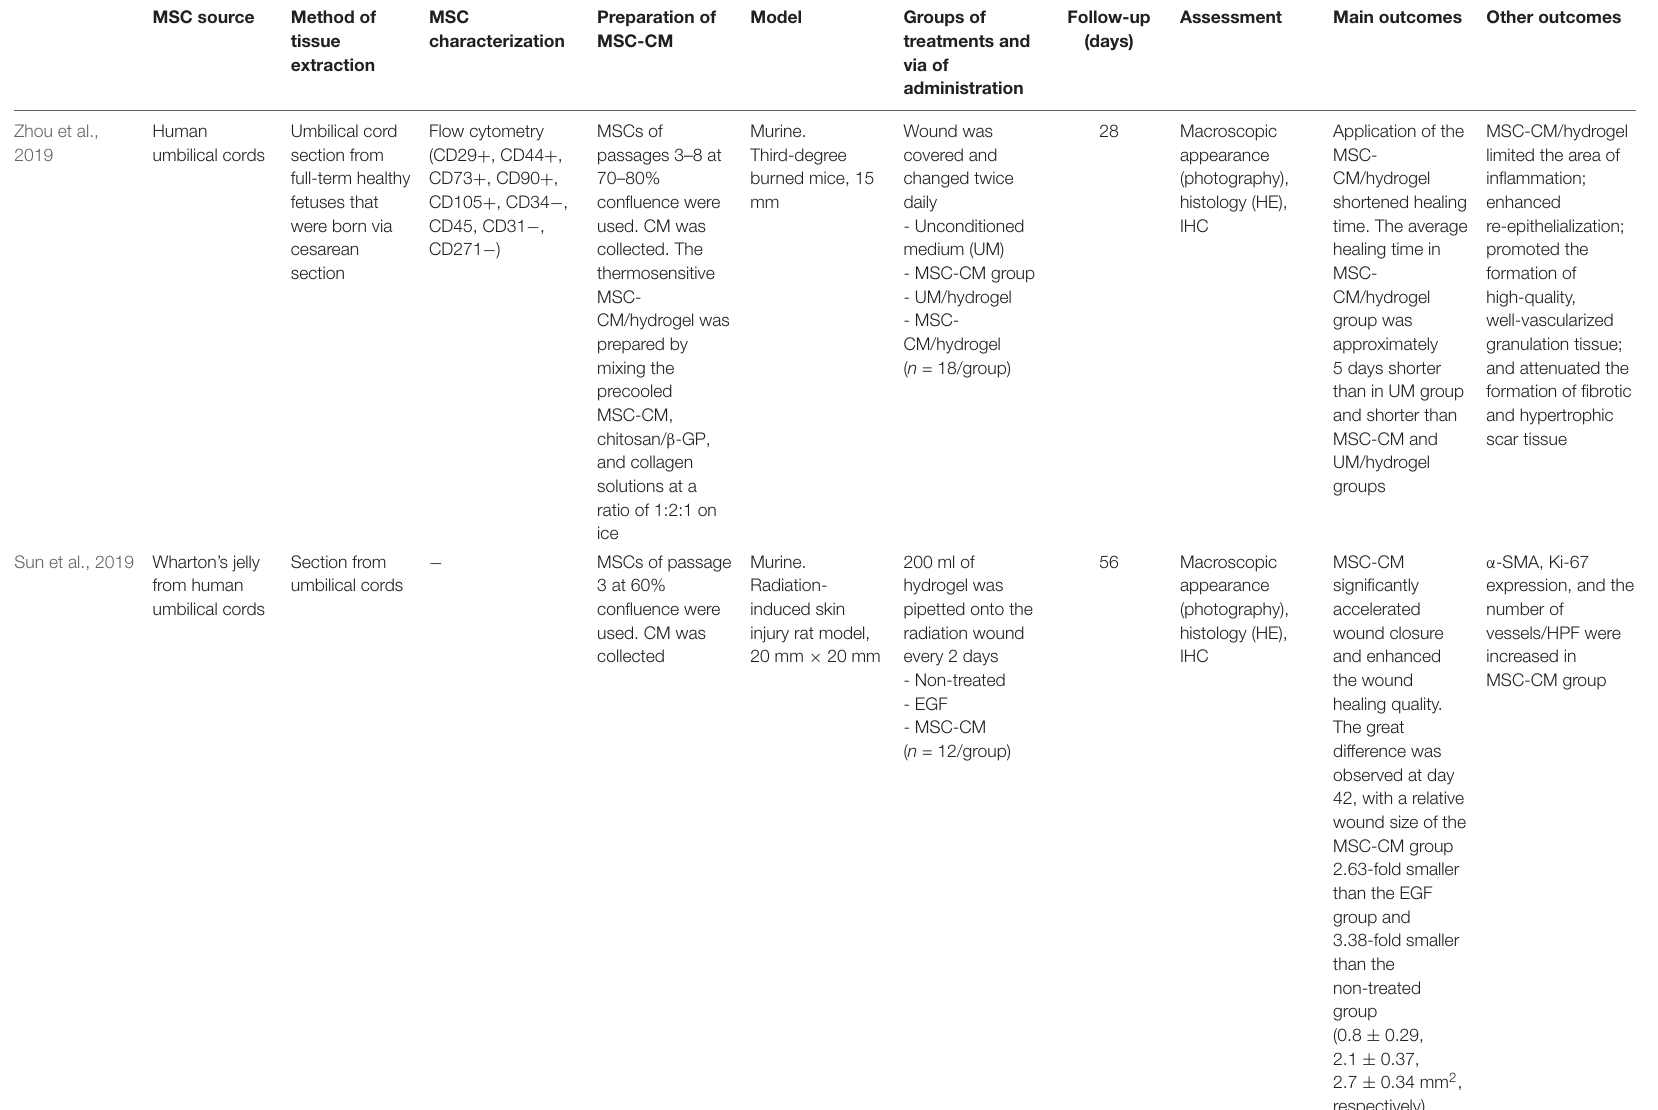
TABLE 3 | Studies regarding mesenchymal stromal cell-conditioned medium for treating other types of wounds in animal